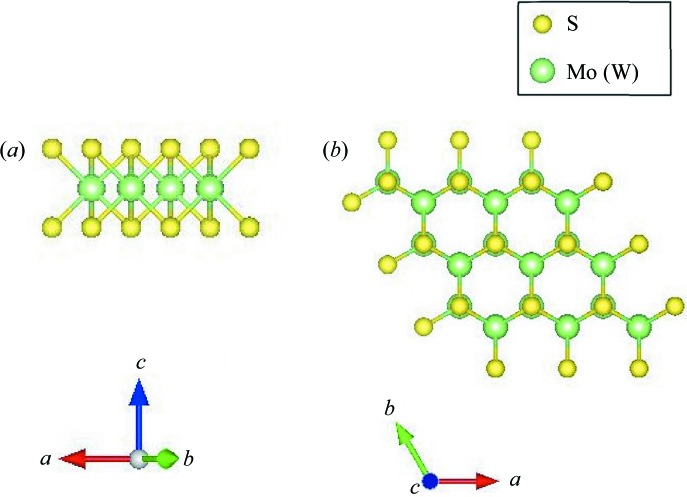
(a) The crystal structure of a single layer of MoS2 (WS2), and (b) its projection along [001].